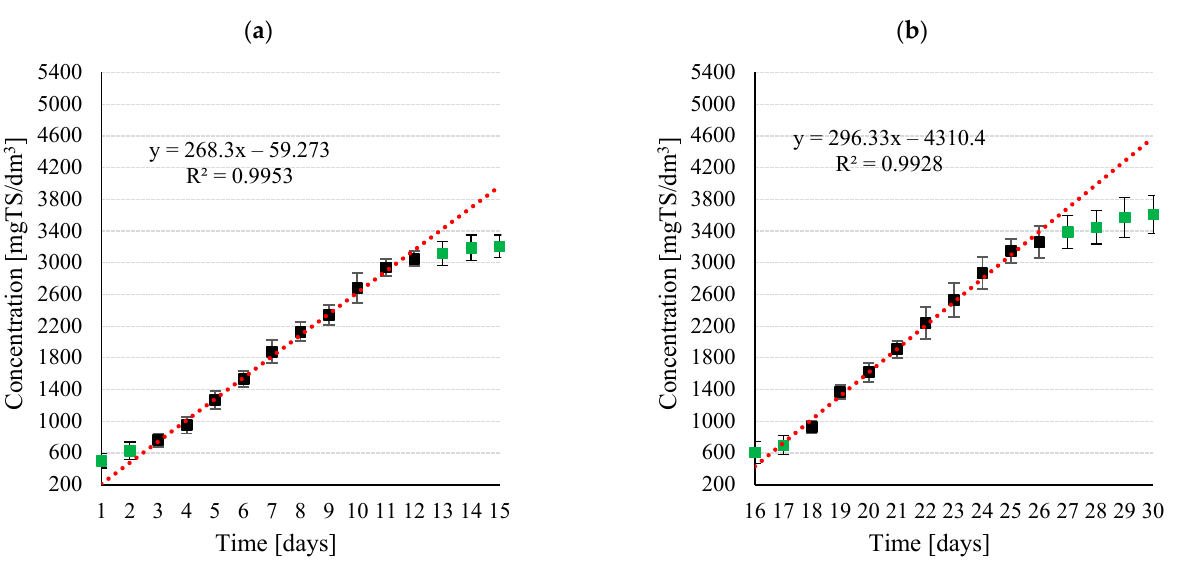
Figure 6. M-BGS biomass production in phases: ( a ) phase 1 (days 1–15) and ( b ) phase 2 (days 16–30) of the H-PBR operation.